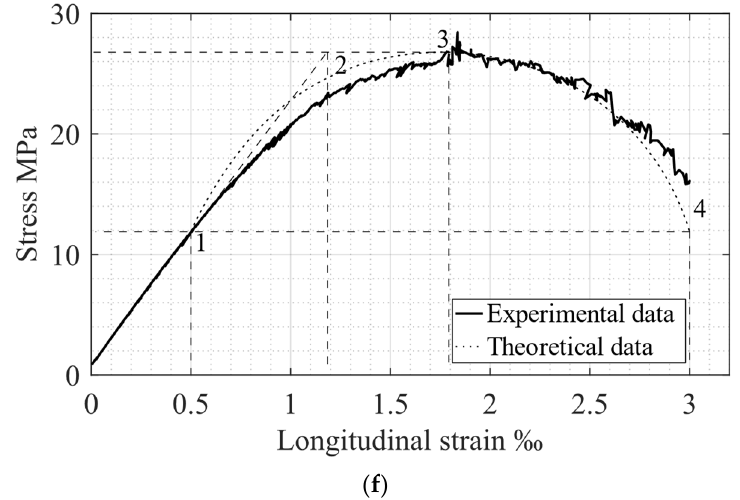
Figure 5. Comparison of experimental and theoretical 𝜎 (cid:3030) − 𝜀 (cid:3030) relationships: ( a ) Specimen Sp1.1; ( b ) Specimen Sp1.2; ( c ) Specimen Sp1.3; ( d ) Specimen Sp2.1; ( e ) Specimen Sp2.2; ( f ) Specimen Sp2.3. Table 5. Comparison of average experimental and theoretical values of the main 𝜎 (cid:3030) − 𝜀 (cid:3030) diagram parameters.